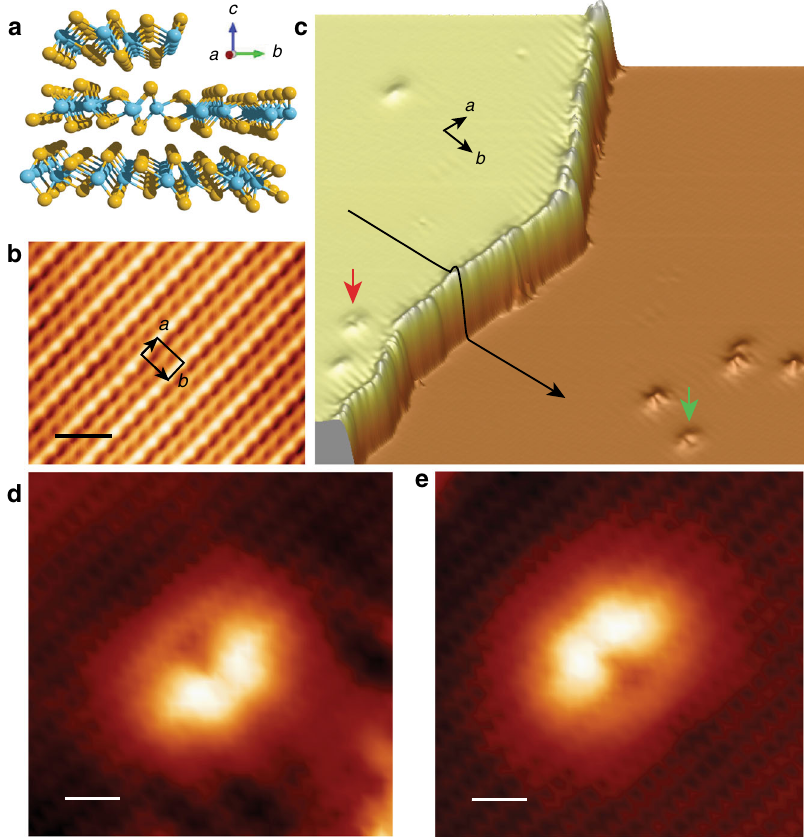
Fig. 1 Topography of WTe 2 . a Schematic illustrating the crystal structure of WTe 2 with a step edge. The W and Te atoms are colored with cyan and orange , respectively. b STM image showing the topography of WTe 2 with atomic resolution. Imaging conditions: V s = 120 mV, I t = 100 pA. The unit cell of the (001) plane is marked. c Pseudo 3D image of WTe 2 showing a step edge. Image size: 60 × 60 nm. The black line is a sectional line drawn across the step. The bright protrusions on both the upper and lower terraces are crystal defects. The red arrow and green arrow mark two typical defects that are mirror- symmetric to each other. Their zoom-in STM images are shown in d , e , respectively. The wave like patterns around the defects and steps in c are the electron standing waves. Imaging conditions of c , d , e : V s = 150 mV, I t = 200 pA. The scale bar in b , d , e corresponds to 1